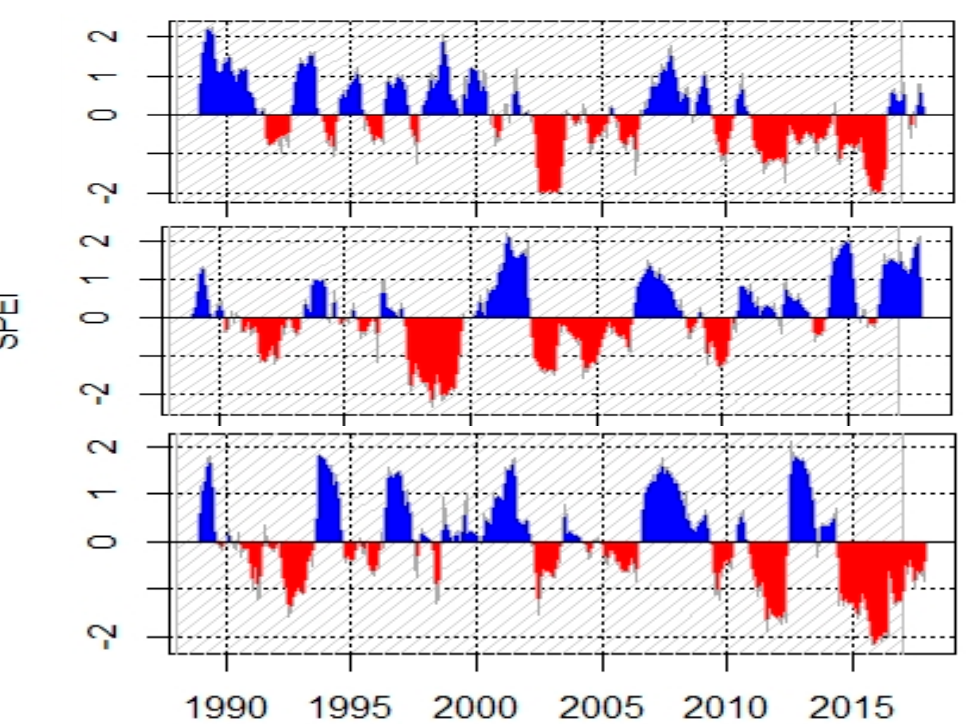
Figure 4. Trends of the Standardized Precipitation Evapotranspiration Index (SPEI) in the lowland ( top ), midland ( middle ), and highland ( bottom ) areas.